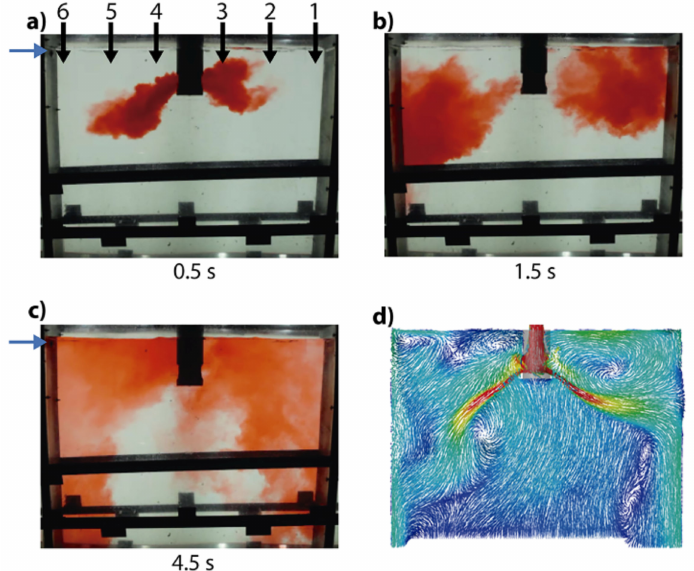
Figure 17. Tracer mixing in the mold model using nozzle A with clogging. ( a ) A total of 0.5 s after injection. ( b ) A total of 1.5 s after injection. ( c ) A total of 4.5 s after injection. ( d ) Numerical velocity field. The numbers indicate the position of the sensors and the blue arrows indicate the position of the ultrasonic transducer.